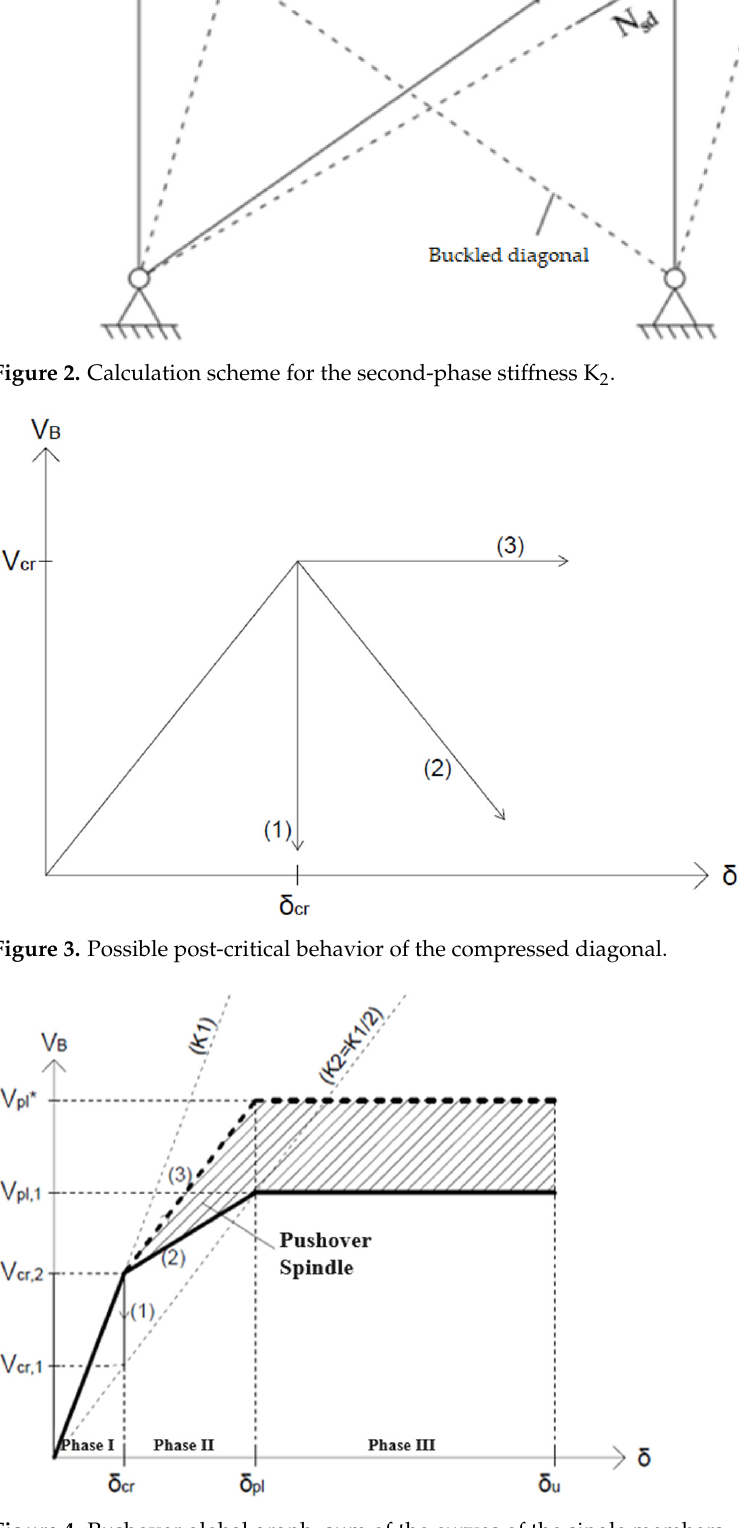
Figure 4. Pushover global graph, sum of the curves of the single members.